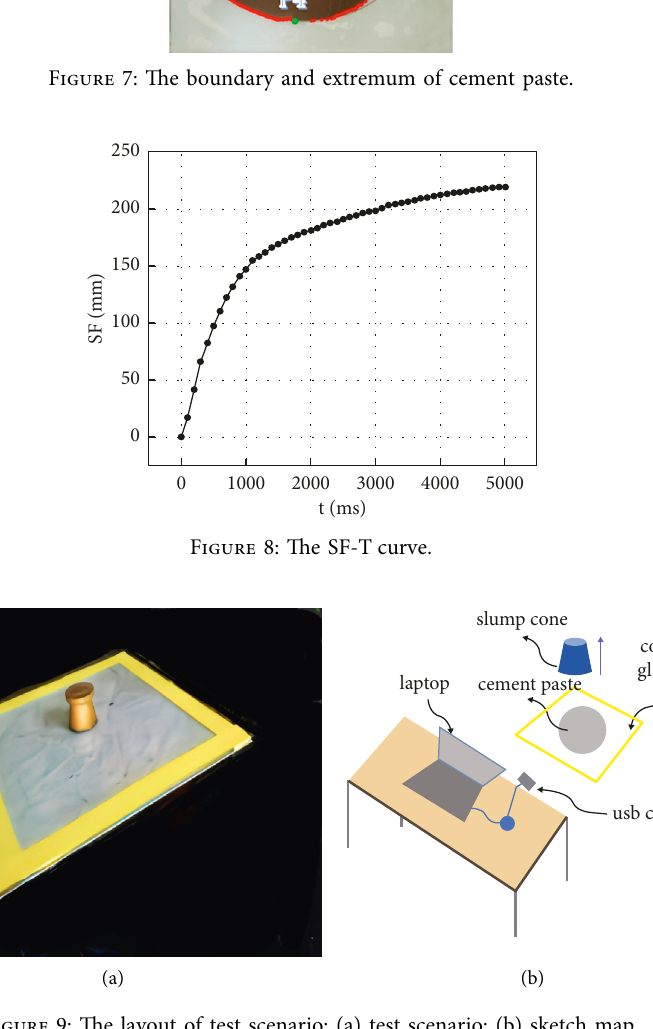
Figure 9: The layout of test scenario: (a) test scenario; (b) sketch